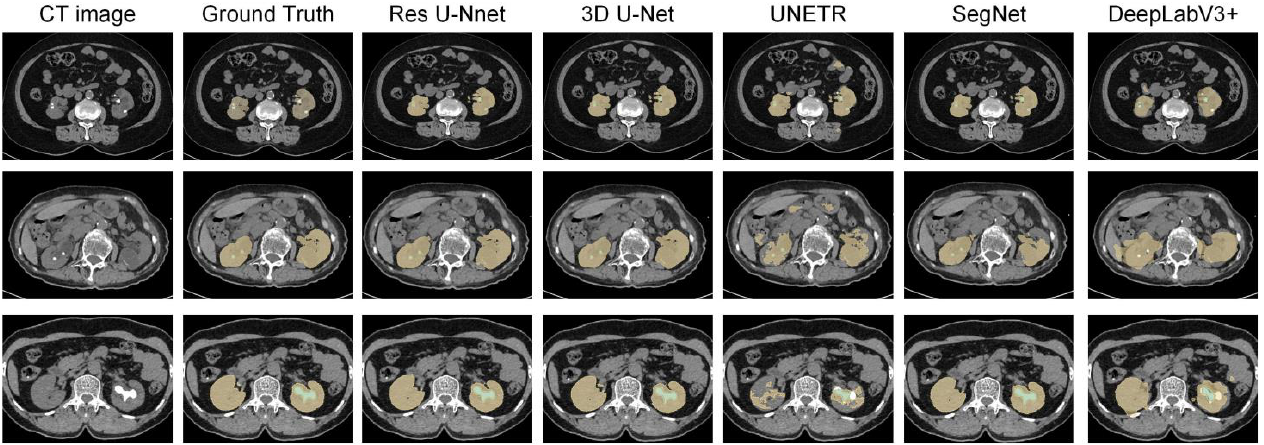
Figure 15. The 2D visual analysis of segmented kidneys and kidney stones predicted by the models trained independently.